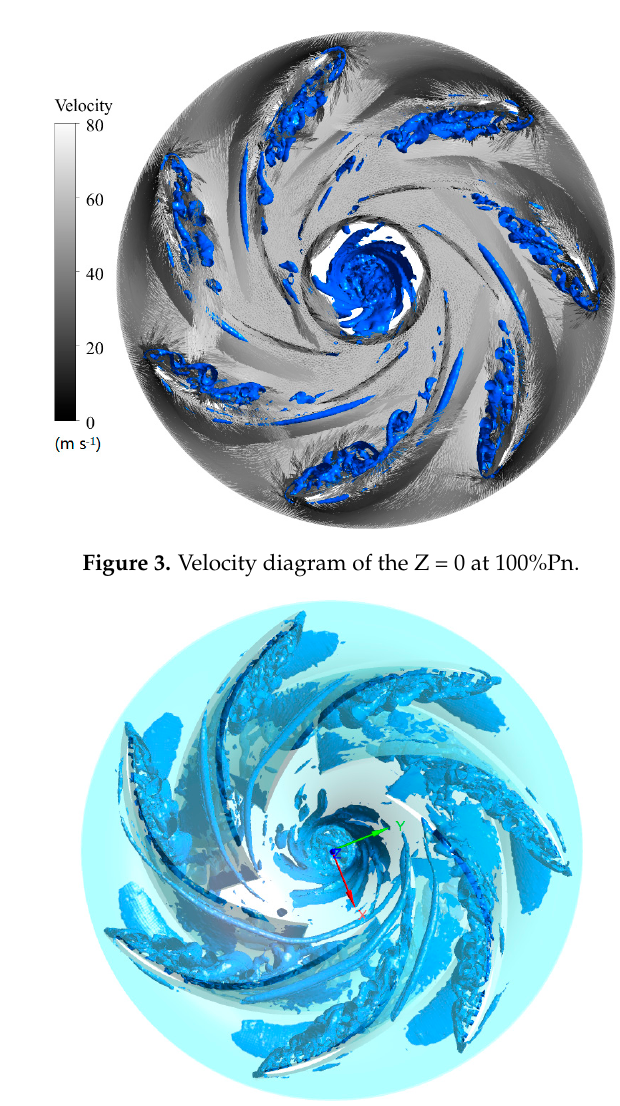
Figure 4. Vortex structures at 100%Pn (10% characteristic scale).